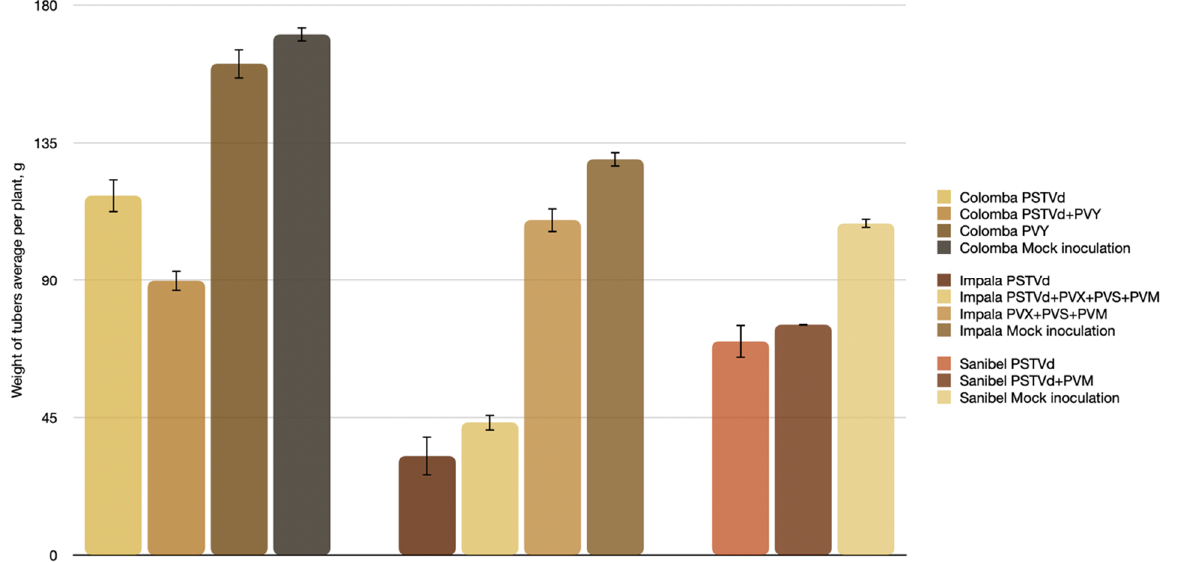
Figure 12. Tubers of cv. Impala at 90 dpi with PSTVd strain NicTr-3, viral, and viral/viroid mixed infection.